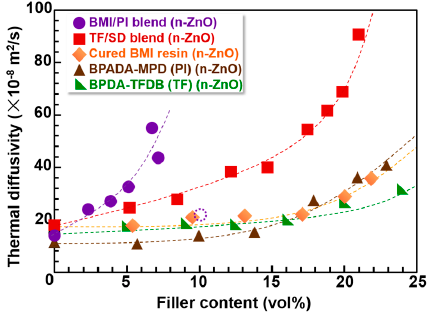
Figure 6. Filler-content dependence of the out-of-plane thermal diffusivities ( D ⏊ ) for various PI, PI blend, and BMI/PI blend composite films. The significantly reduced D ⏊ value observed for the BMI/PI blend film with a filler content of 10 vol % is denoted by a dotted circle.